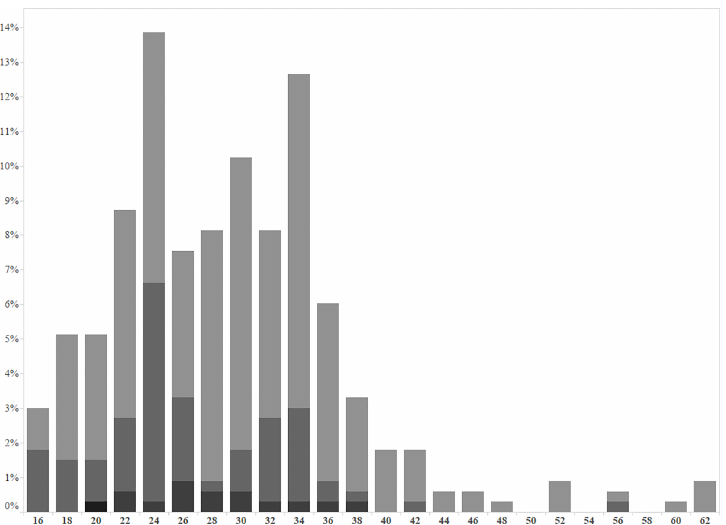
Fig 3. Histogram of calving intervals (in months). The x-axis shows the time interval (months) and the y- axis the percentage of animals. The difference in parity of the animalsis indicatedthrough grey scales with lighter bars (parity 1), medium bars (parity 2) and darker bars (parity (cid:21) 3) with lower parity animalshaving lighter bars.